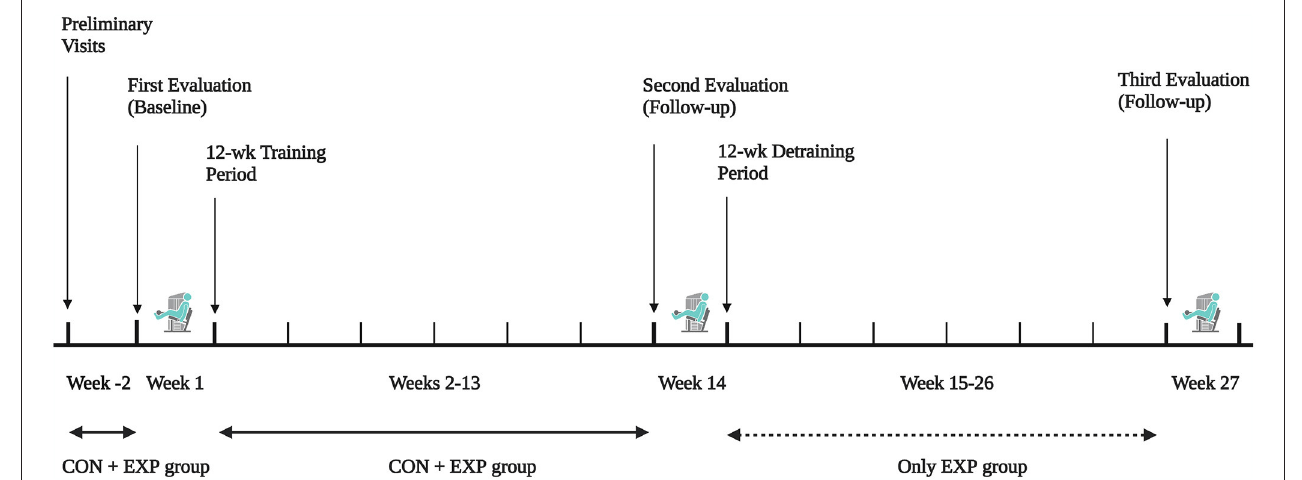
FIGURE 1 | Schematic overview of study